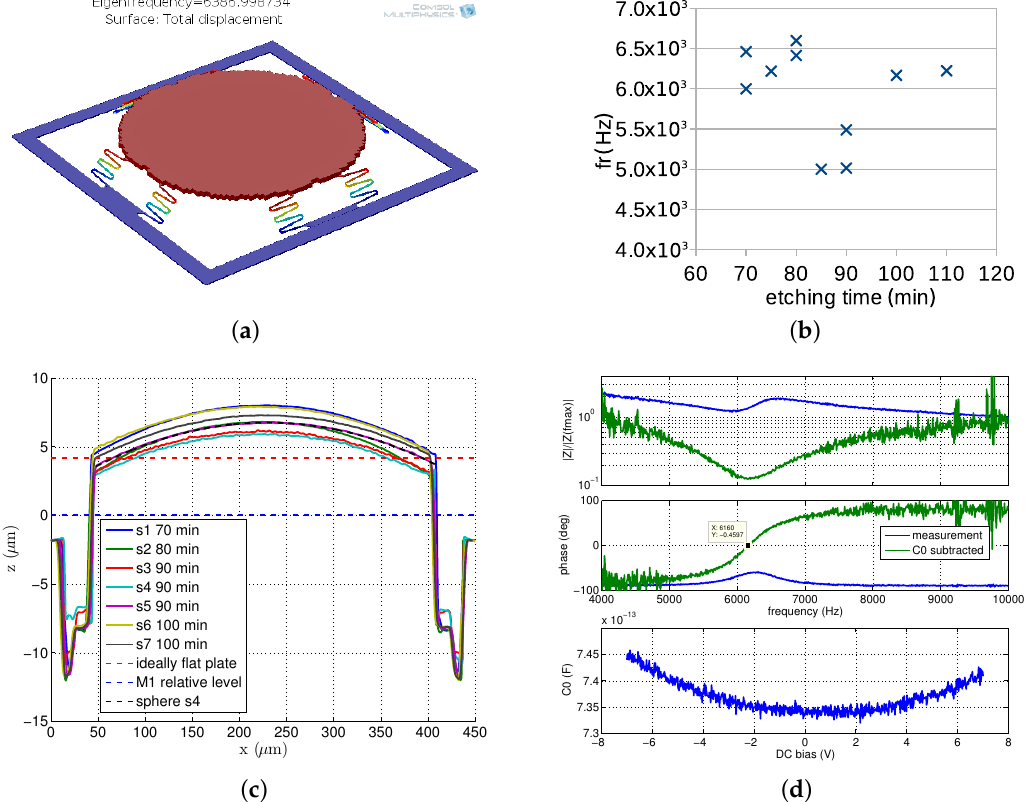
Figure 15. Circular z -axis accelerometer (P) on Bailed chip: modal simulation indicating eigenfrequency at 6387 Hz ( a ); measured resonance frequencies of several samples obtained after different etching time ( b ); profiles of several samples ( c ); and example of impedance measurement indicating resonance at 6160 Hz ( d